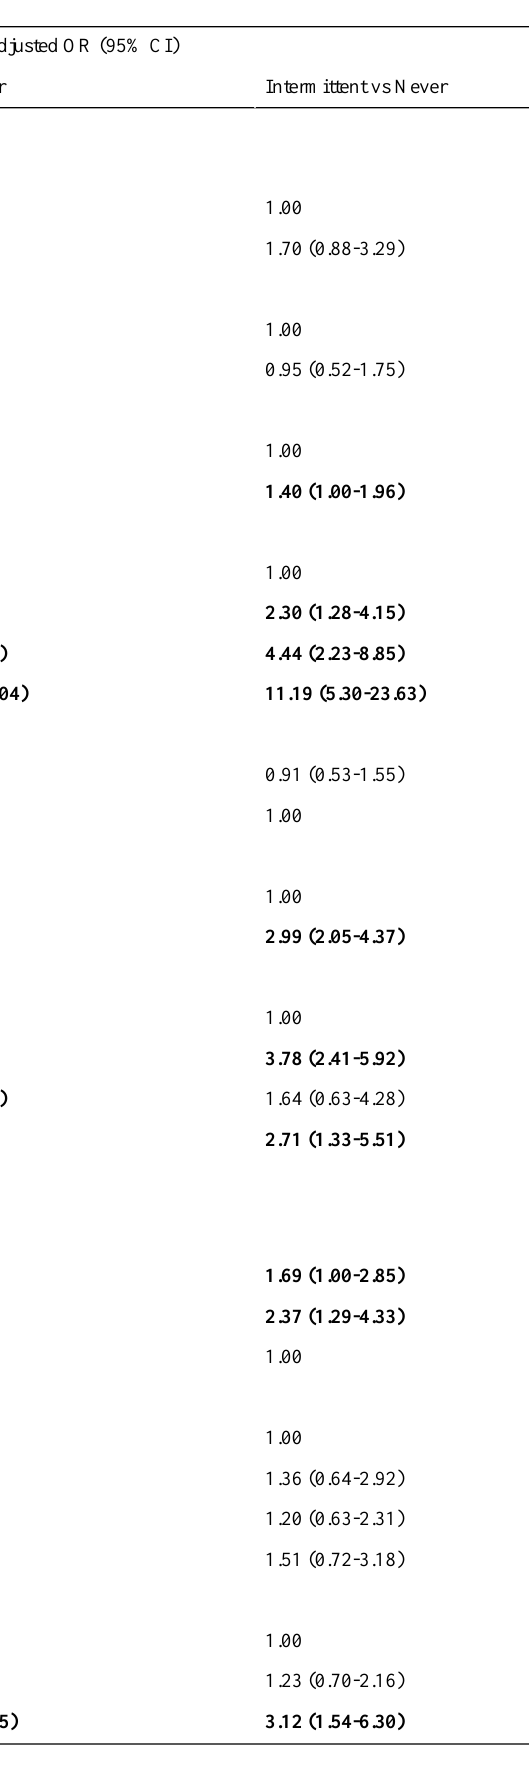
Bivariate Age-Adjusted OR (95% CI)